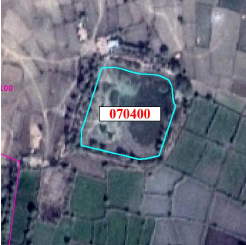
Figure 7 . The lake patch (CC2 code is 070200) is not edited according to the water level on the image.